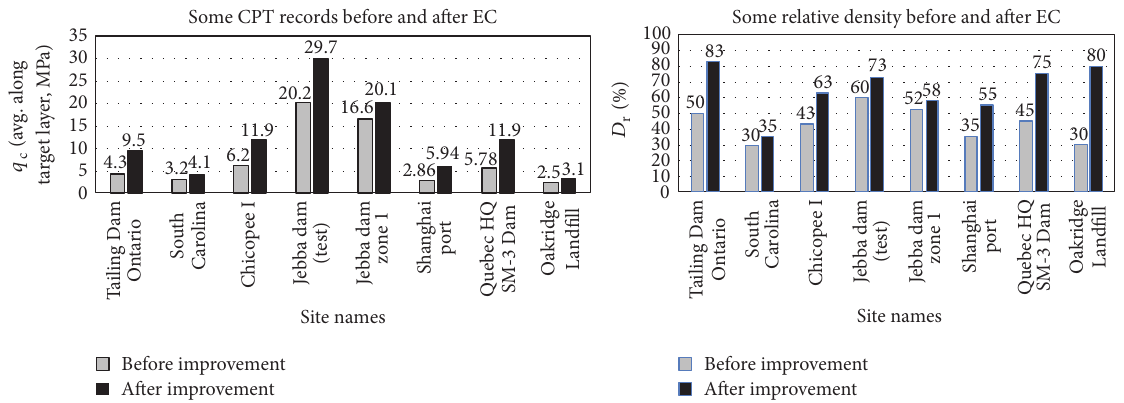
Figure 15: CPT and 𝐷 𝑟 Results before and after EC in some sites in the